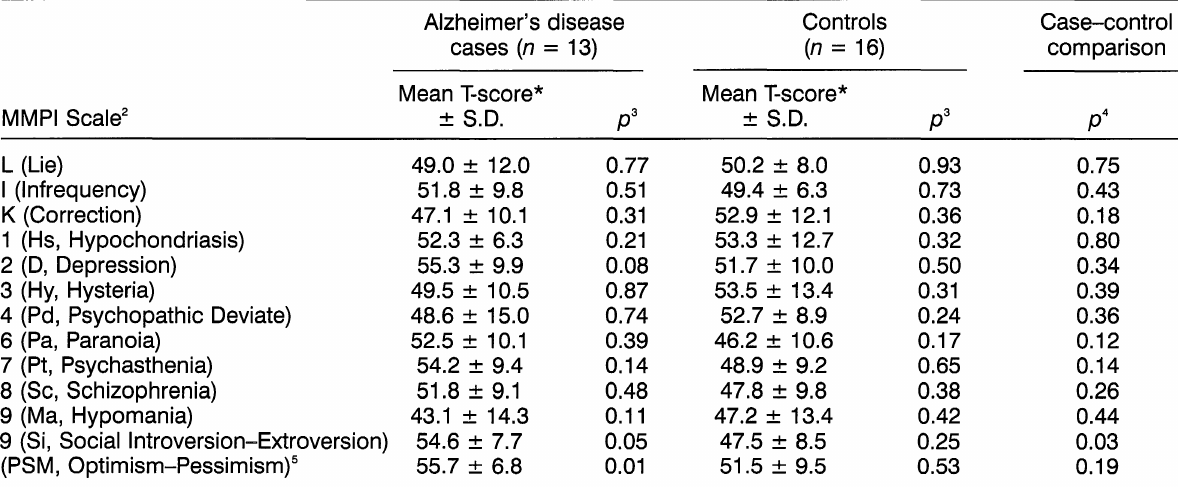
TABLE II. Mean scores of Alzheimer's diseases cases and controls on the scales of the Minnesota Multiphasic Personality Inventory